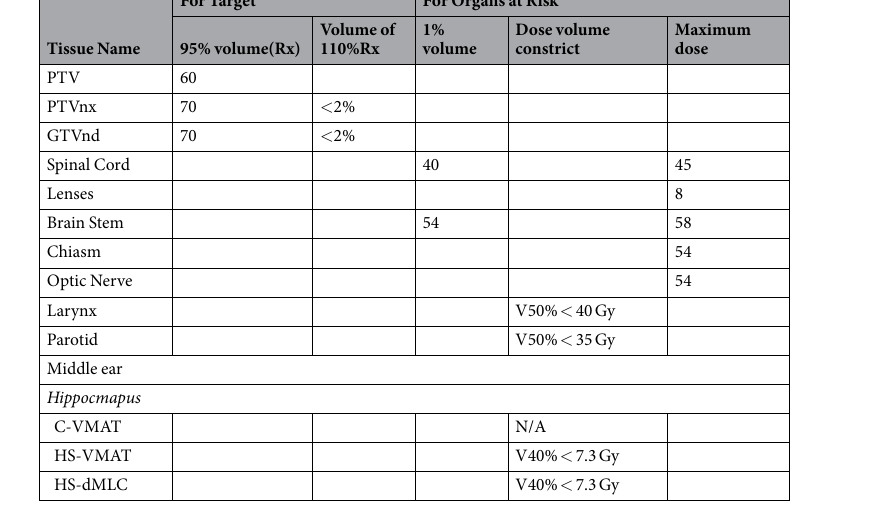
Table 1. The prescription for all the